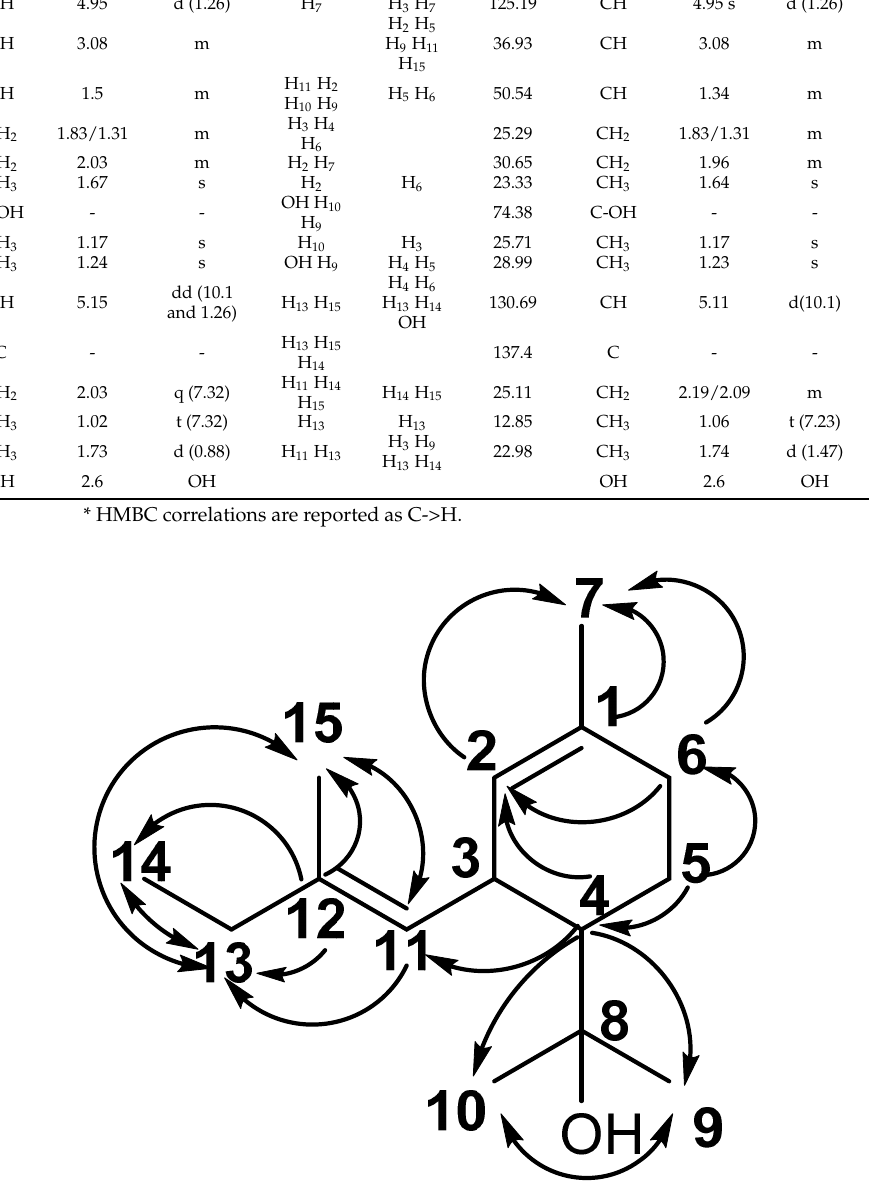
Figure 4. Structure of 42a and schematic representation of HMBC correlations .